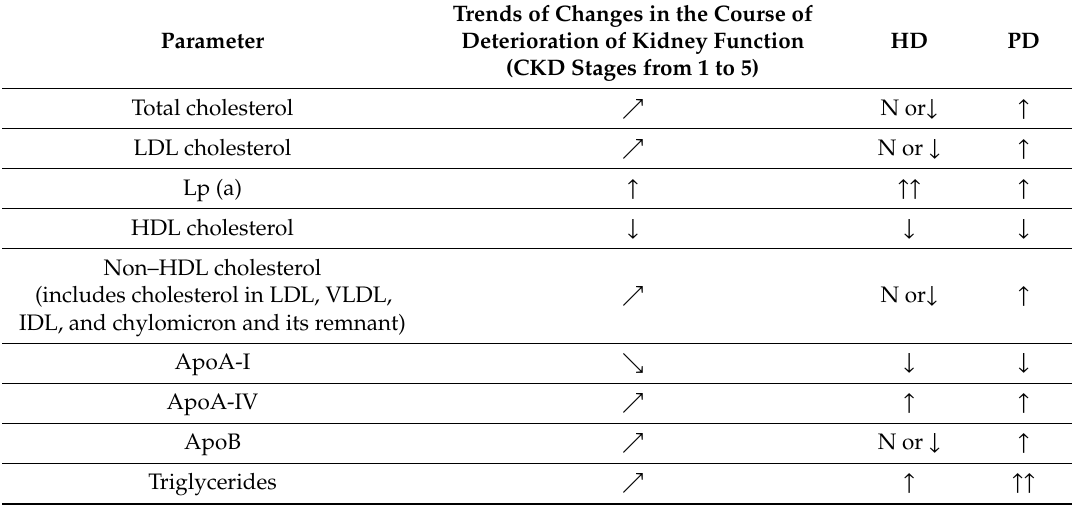
Table2. Changesoflipidparametersinnon-dialyzedanddialyzedpatientswithCKD.IDL:intermediate- density lipoprotein, LDL: low-density lipoprotein cholesterol, VLDL: Very low-density lipoprotein cholesterol, HD: hemodialysis, PD: peritoneal